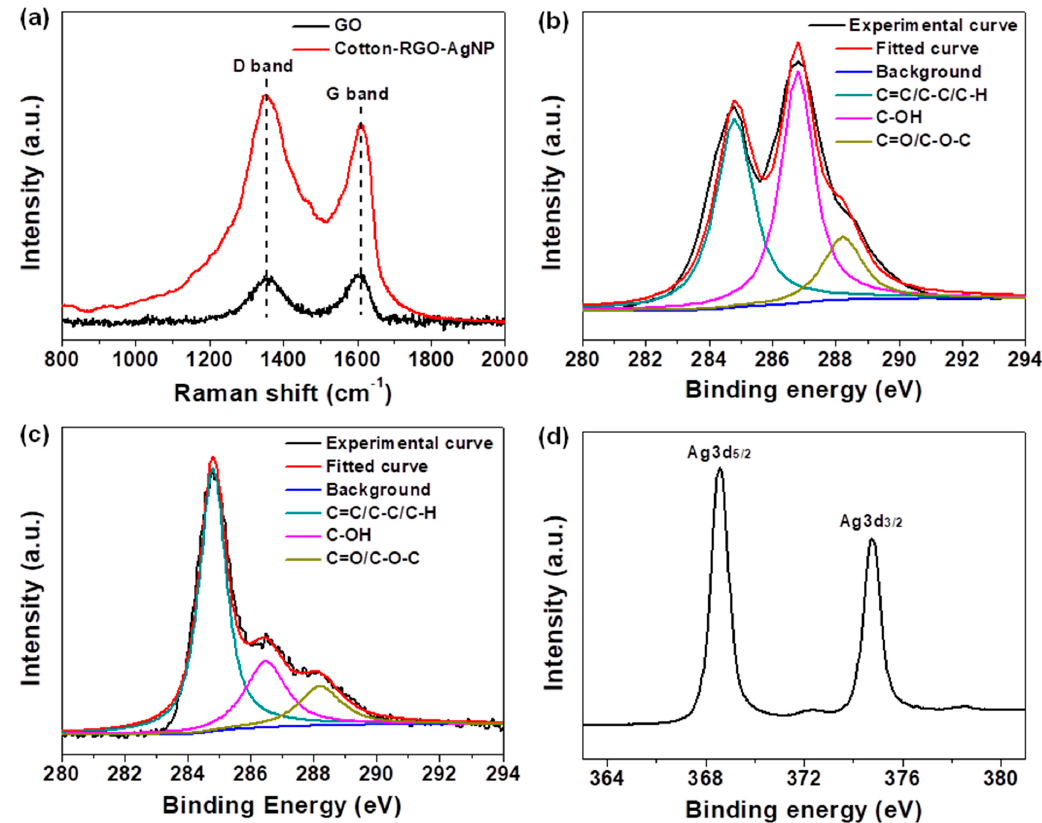
Figure 4. ( a ) Raman spectra of the purchased GO powder and currently developed cotton-RGO-AgNP fiber, exhibiting obvious D and G bands; ( b ) high-resolution XPS C1s spectrum of GO powder; ( c , d ) high-resolution XPS spectra of cotton-RGO-AgNP fiber for the C1s and Ag3d regions, respectively.